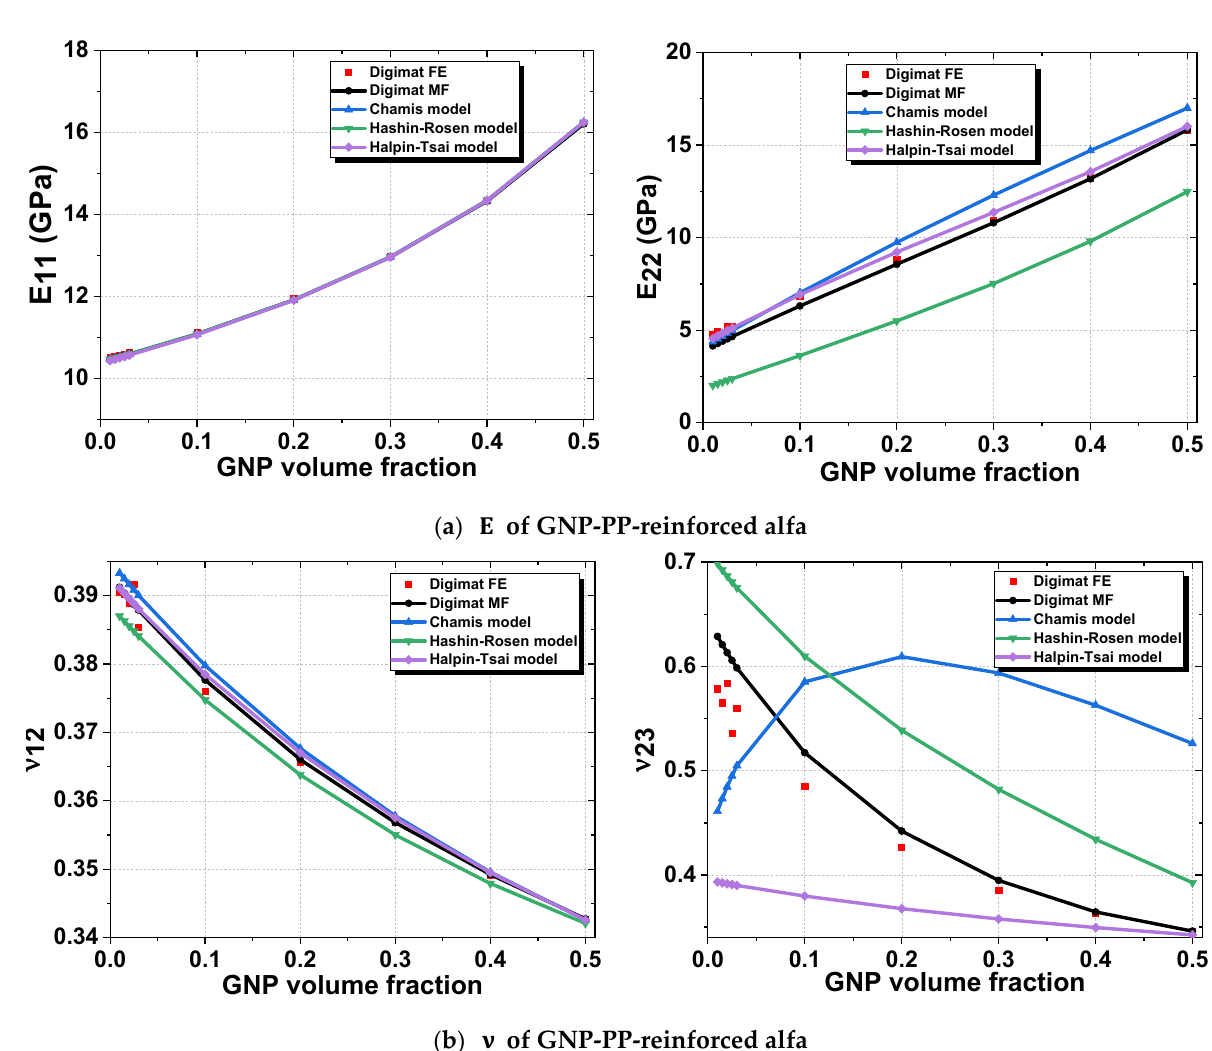
Figure 12. Elastic properties of GNP-PP matrix reinforced by alfa aligned fiber (50 vol%) vs. GNP volume fraction. ( a ) Young’s modulus E . ( b ) Poisson’s ratio ν .